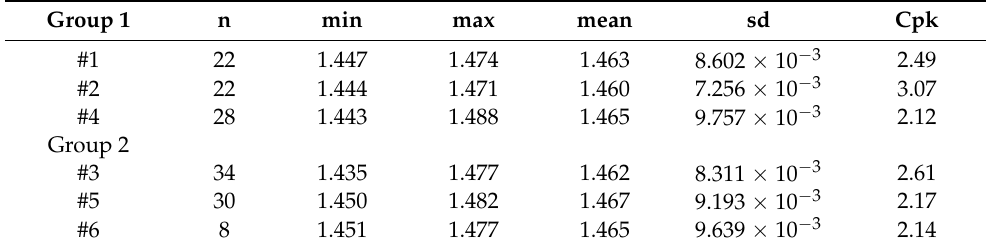
Table 2. Batch descriptive